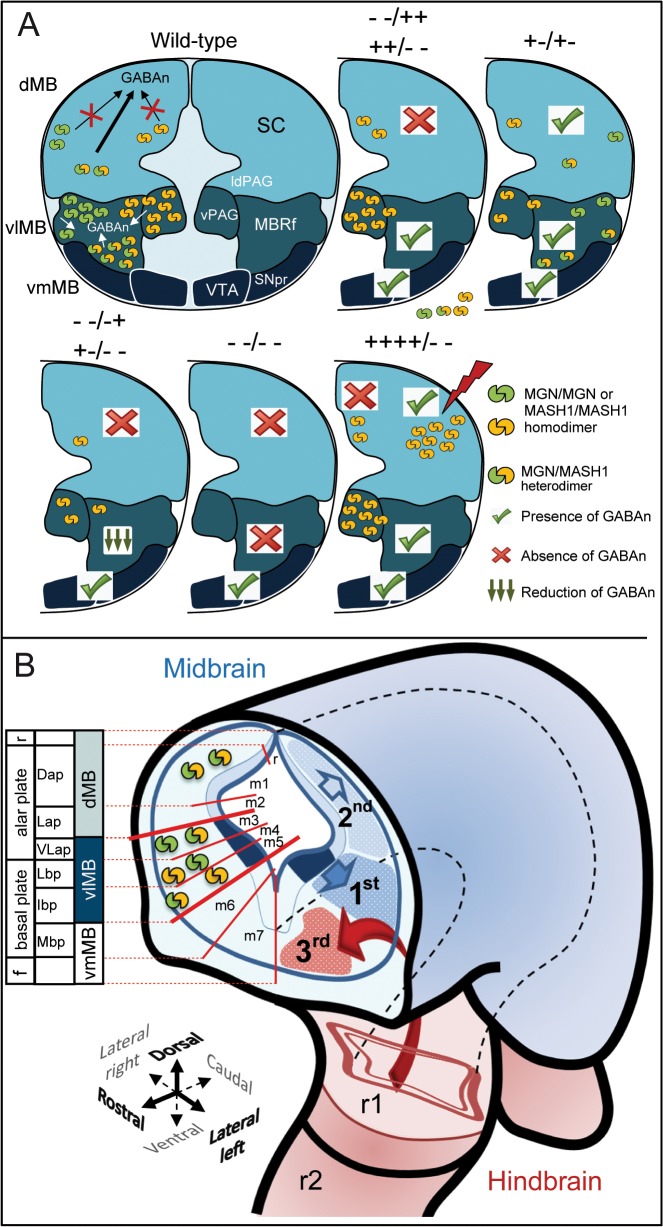
Summary model of the dorsal/ventral mechanisms underlying MB GABAergic neurogenesis.
(A) Two genes, Mgn and Mash1, functioned as selectors of GABAergic identity in the MB through different dorsal/ventral mechanistic actions at different times. The MGN/MASH1 heterodimers (green shape coupled with yellow) appear essential for the induction of dorsal GABAn (m1 and m2 domains) that generate GABAn in the colliculi, laterodorsal periaqueductal gray area (ldPAG) and the ventrolateral periaqueductal gray area (vPAG). MGN or MASH1 homodimers (shapes coupled with the same color) are not sufficient to trigger GABAergic identity, and synergistic cooperation between MGN and MASH1 factors to form heterodimers is essential for the acquisition of dorsal GABAergic identity. The mechanism operating in the vlMB area (m3, m4, and m5 domains), which gives rise to the ventral PGA and reticular formation nuclei (MBRf) GABAn, appeared to be different from that in the dorsal area. In this model, the MGN/MASH1 heterodimer is not a prerequisite for the induction of ventrolateral GABAn, with either homodimer being sufficient alone and following a dose-dependent mechanism. The GABAergic phenotype observed in mutant mice is depicted with a green tick or red cross to denote the presence or absence of GABAn, respectively. (B) MB GABAn arise during three waves of neurogenesis, at both specific developmental times and specific locations. The earliest wave of GABAergic neurogenesis (1st) starts at E10.5 in the presence of Mgn and/or Mash1, without preference. The second phase (2nd) takes place two days later at E12.5 in the dMB. The third population (3rd), corresponding to the GABAn of the SNpc and VTA, appears at E14.5. These different mechanisms define a new model for dorsal and ventrolateral GABAergic neurogenesis. Red lines delimitate the embryonic MB into seven subdomains (m1-m7) along the dorsal/ventral axis, characterized by the expression of specific transcription factors [10] and their corresponding MB plates, established by [22]. (−−/++; ++/−−) stand for Mgn and Mash1 single knock-out embryos, respectively. (−+/−+; −−/−+; −+/−−) stand for compound embryos; (−−/−−) stands for double knock-out embryos and ++++/−− stands for overexpression of Mgn cDNA in Mash1
−/− genetic background embryos. Abbreviations: f, floor plate; r, roof plate; Dap, dorsal alar plate; Lap, lateral alar plate; VLap, ventrolateral alar plate; Lbp, lateral basal plate; Ibp, intermediate basal plate; Mbp, medial basal plate.”